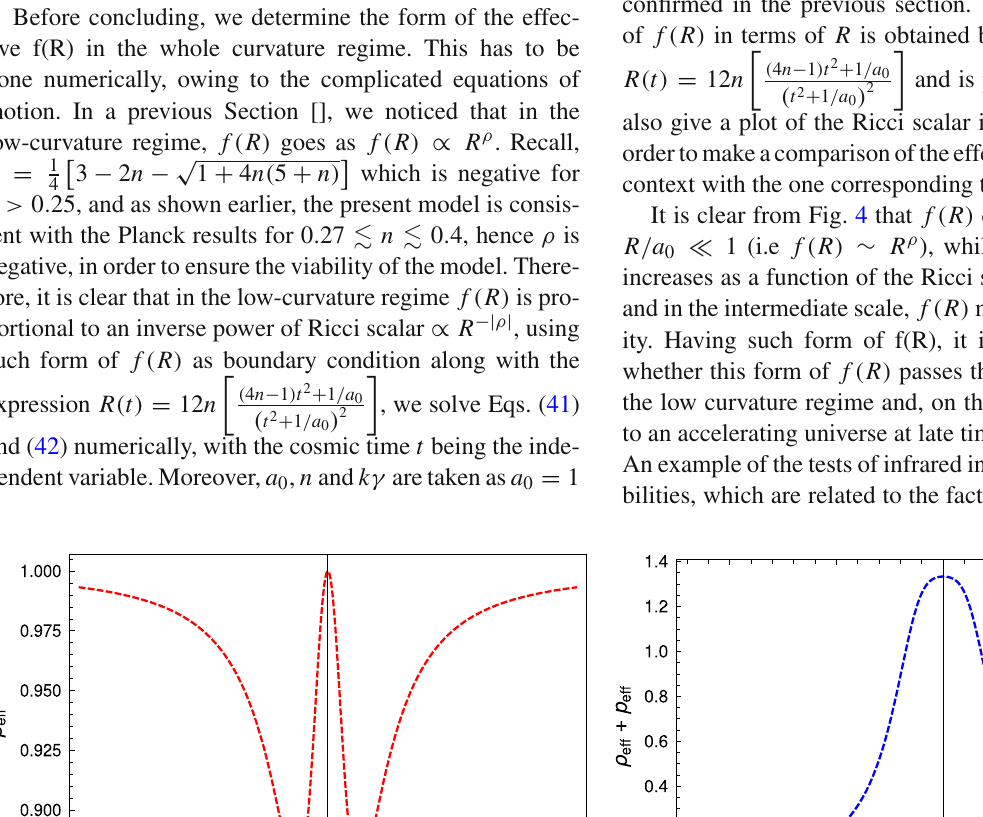
(in reduced Planck units), n = 1 / 3 and k γ = 1, respec- tively; so in effect we consider the matter bounce scenario.